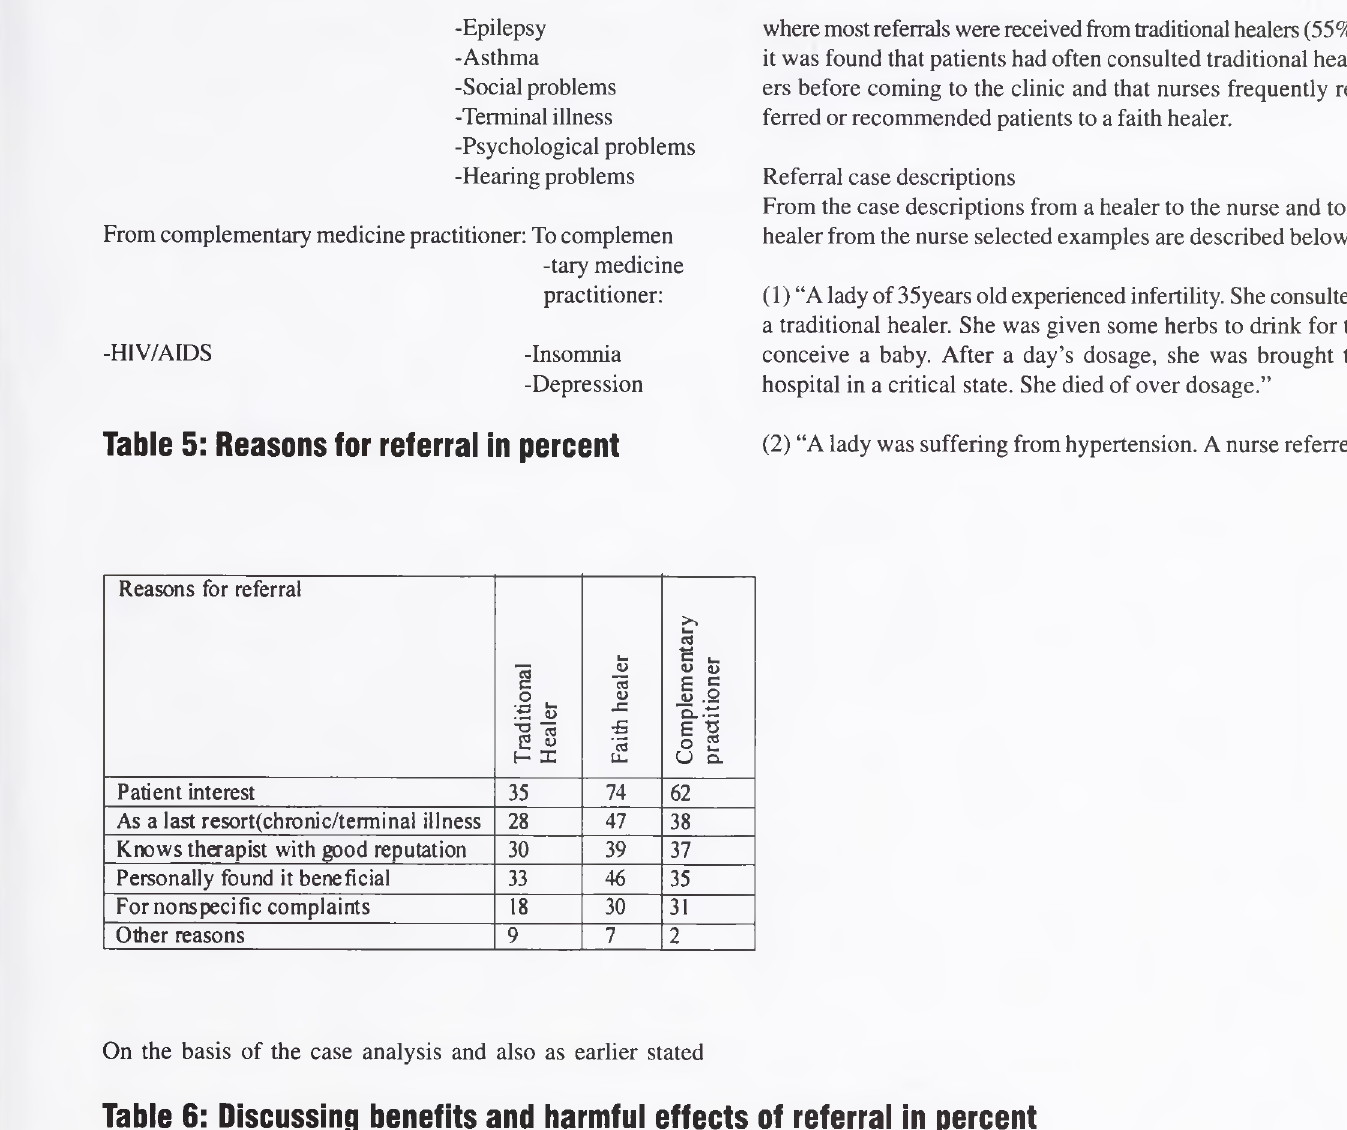
Table 6: Discussing benefits and harmful effects of referral in